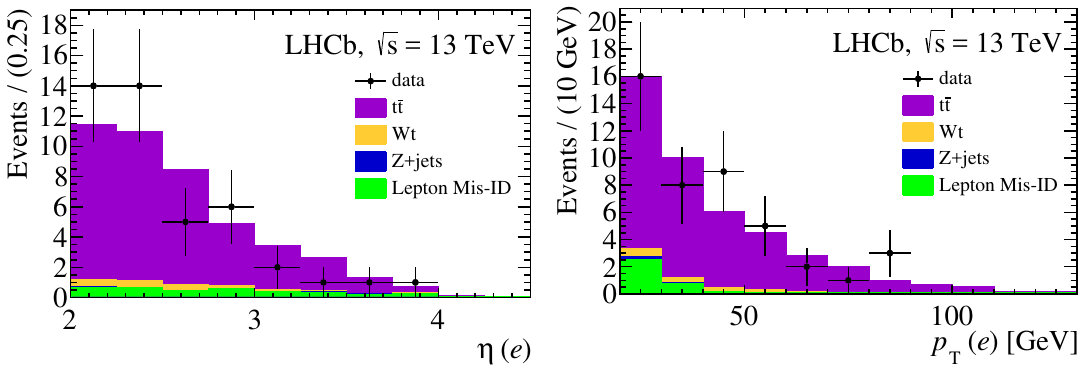
Figure 2 . The electron (left) (cid:17) and (right) p T distribution in data compared to the expected contributions. The tt signal yield is determined to be the number of selected events minus the sum of the expected backgrounds. The multiboson background is determined to be